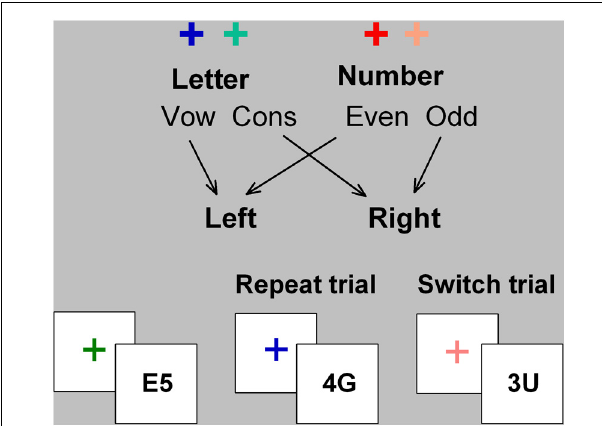
FIGURE 1 | Cued-trials task switching paradigm. Letter and number classification tasks were consistently mapped to hot or cold color cues (cross) and to left and right hand responses.The stimulus consisted of a letter and a number that are incongruently mapped to response hand (i.e., on mapping shown here, if letter is a vowel, number will be odd, and vice versa ). Cue color changed on every trial and validly signaled the relevant task for the upcoming stimulus.The cue was removed upon stimulus onset and the stimulus did not contain information about which task was relevant on that